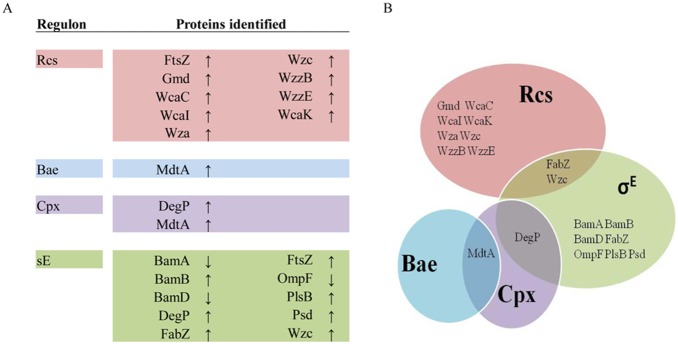
List of proteins belonging to cell envelope stress response pathways whose level changes upon LptC depletion.A. Relative abundance is calculated as the ratio beetween FL905 grown under permissive and non permissive conditions: ↑, increased; ↓, decreased (see Tables 1, 2. 4). B. Venn diagram showing functions whose regulations is shared by multiple envelope signaling systems.